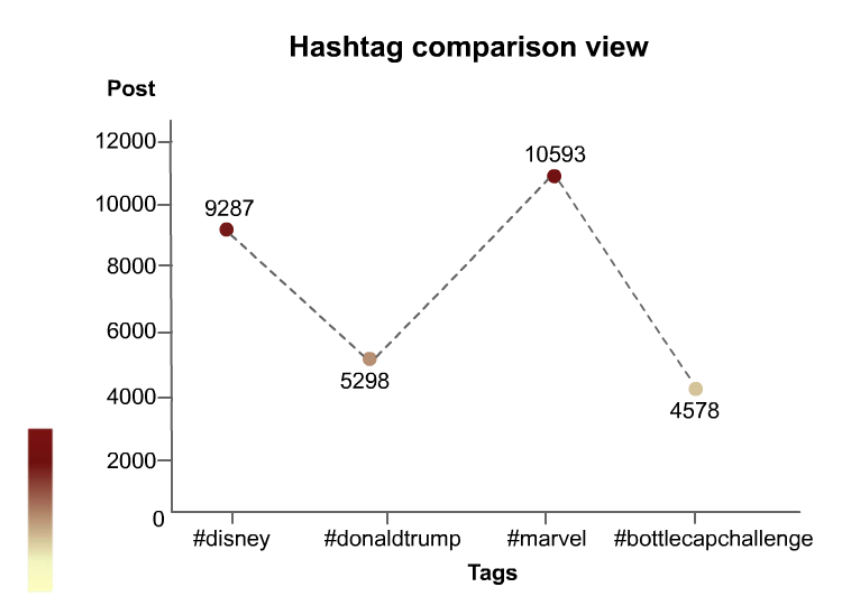
Figure 13 line chart of peak value